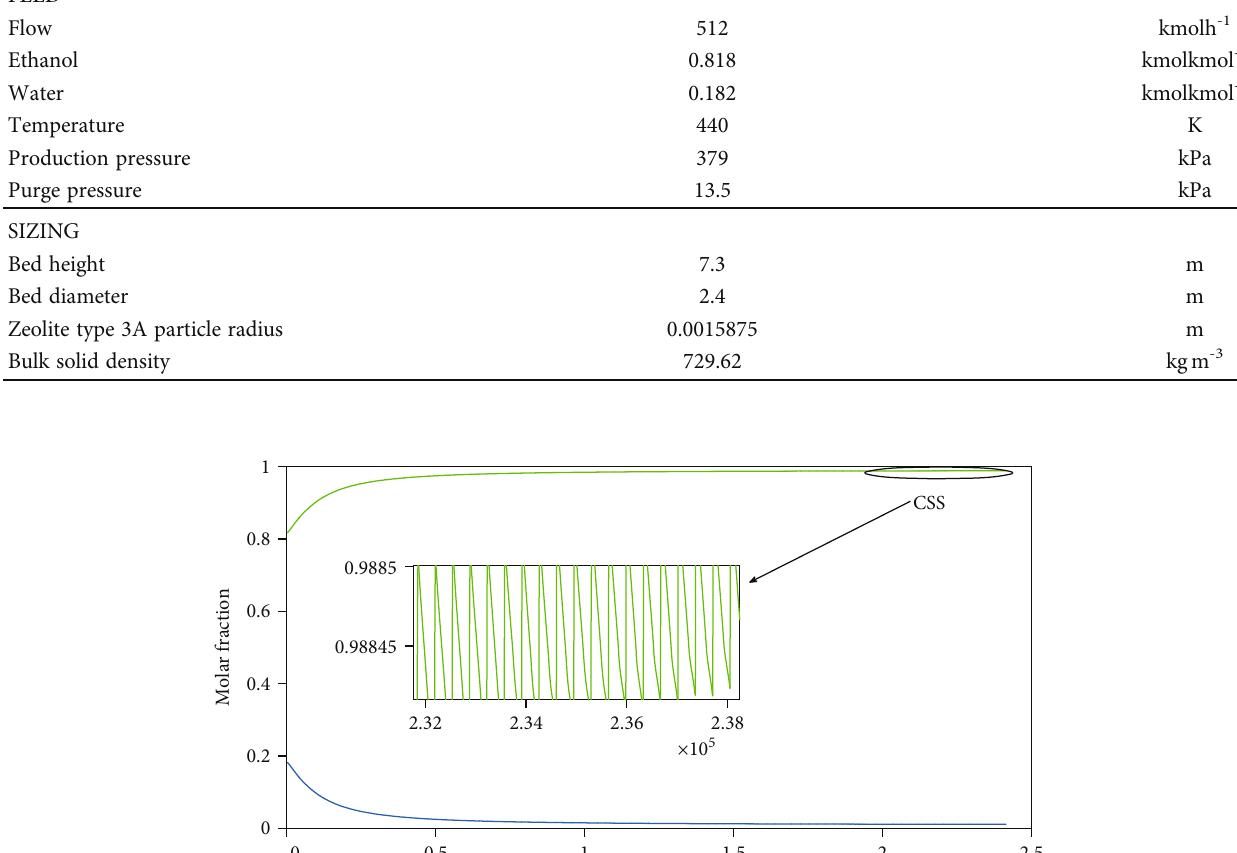
Table 6: Start-up parameters of the PSA process for the puri fi cation and production of bioethanol. FEED